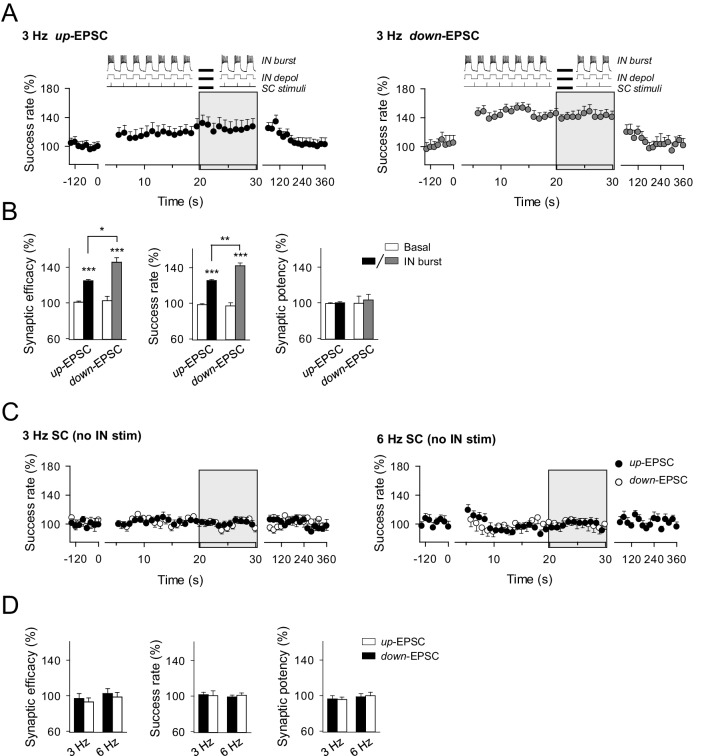
Effects of phase-locked activity between interneuron and excitatory synaptic activity.(A) Averaged relative changes of success rate over time during a stimulation paradigm consisting of SC stimuli at 3 Hz and bursts of interneuron APs (top panel schemes, and described in Figure 5), when SC stimuli coincided with the interneuron up-state, i.e., during the interneuron bursts of APs (n = 6, left), or down-state, i.e., during the resting state between two consecutive interneuron bursts of APs (n = 5; right). (B) Relative changes of synaptic parameters for conditions shown in A. Synaptic efficacy up: p<0.001; paired t test. Synaptic efficacy down: p<0.001; paired t test. Synaptic efficacy up vs down: p=0.016; unpaired t test. (C) Relative changes of success rate over time for up-EPSCs and down-EPSCs, without interneuron stimulation, evoked by SC stimulation at 3 Hz (n = 8) and 6 Hz (n = 11). (D) Relative values of synaptic parameters in the absence of interneuron stimulation. SC stimulation 3 Hz (n = 8; p>0.05; paired t test) and 6 Hz (n = 11; p>0.05; paired t test). *p<0.05, **p<0.01, ***p<0.001. Error bars indicate SEM.